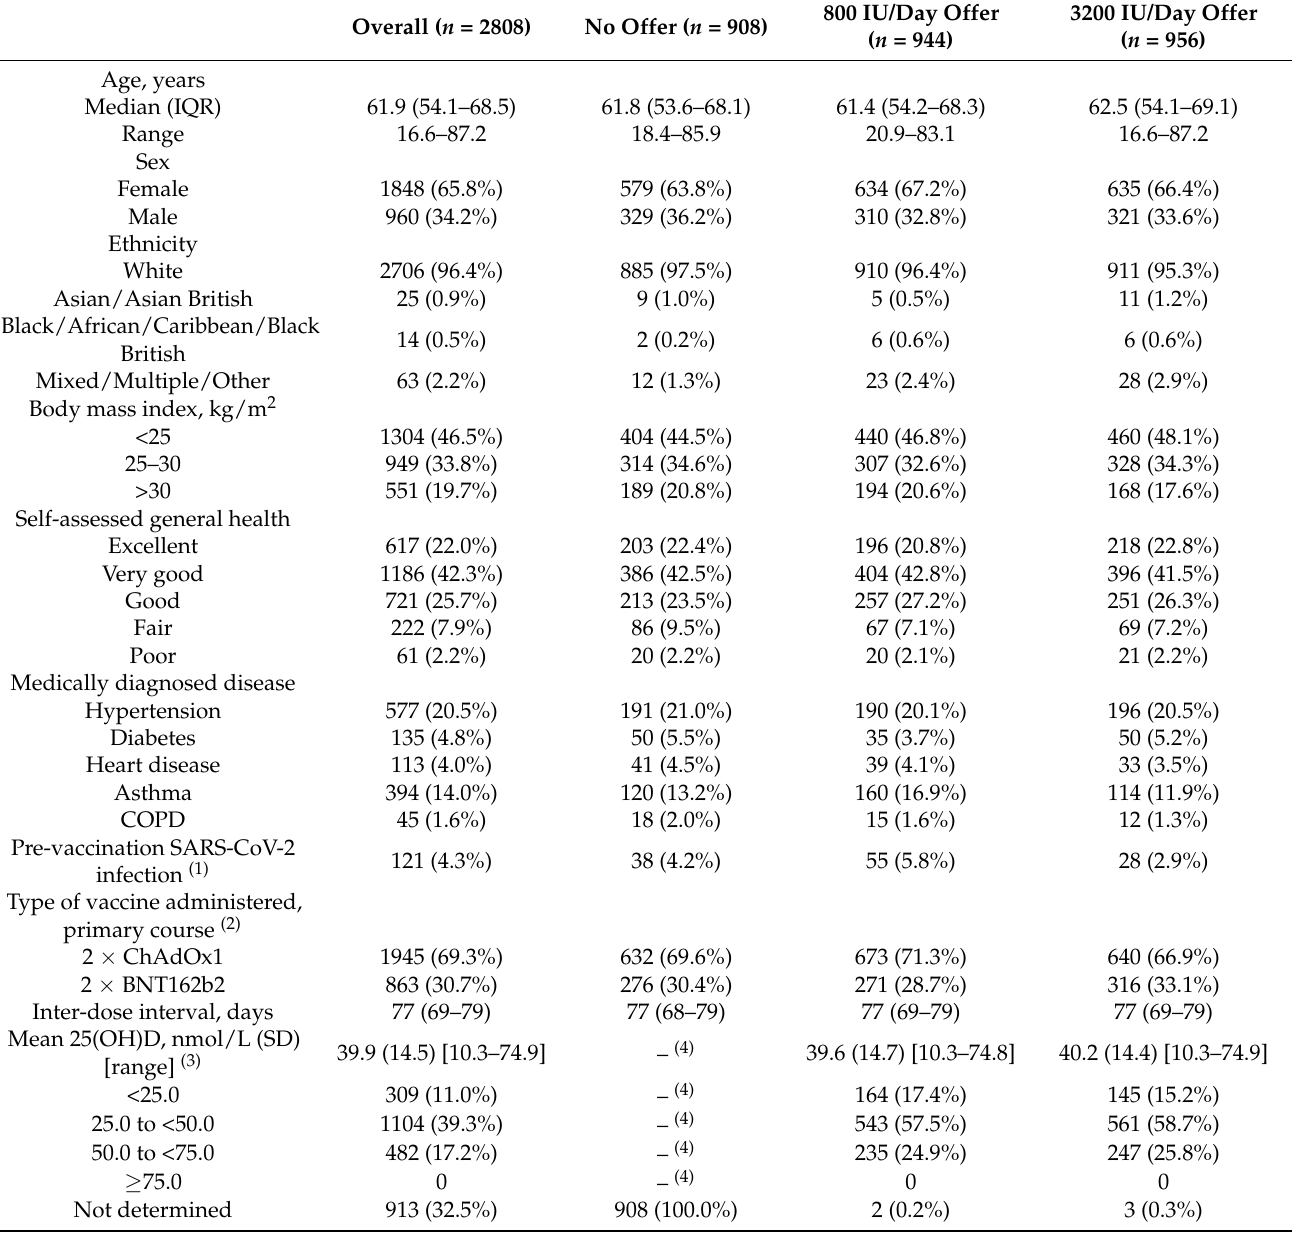
Table 1. Baseline characteristics of participants contributing data to vaccine efficacy analysis (sub- study 1), by